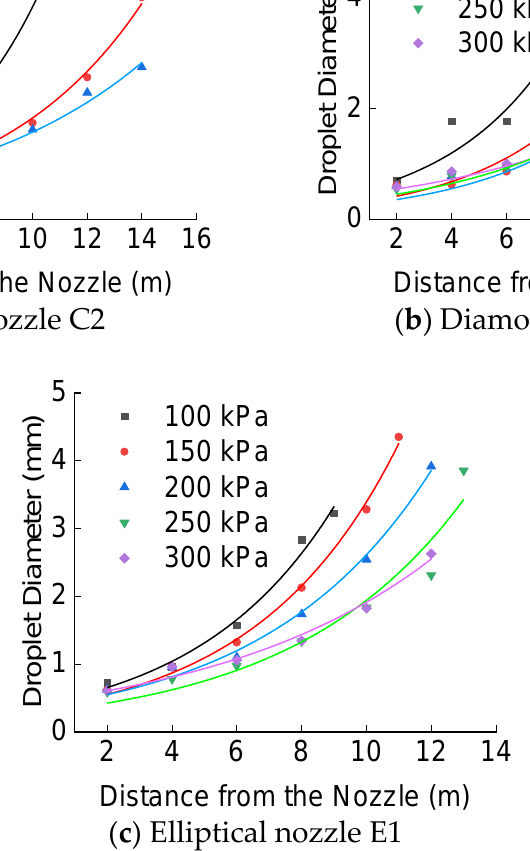
Figure 12. Relationship between average droplet diameter and distance from the nozzle. (C2 refers to the circular nozzle with a diameter of 5 mm; D2 refers to the diamond nozzle with an aspect ratio of 1.32; E1 refers to the elliptic nozzle with an aspect ratio of 1.43).